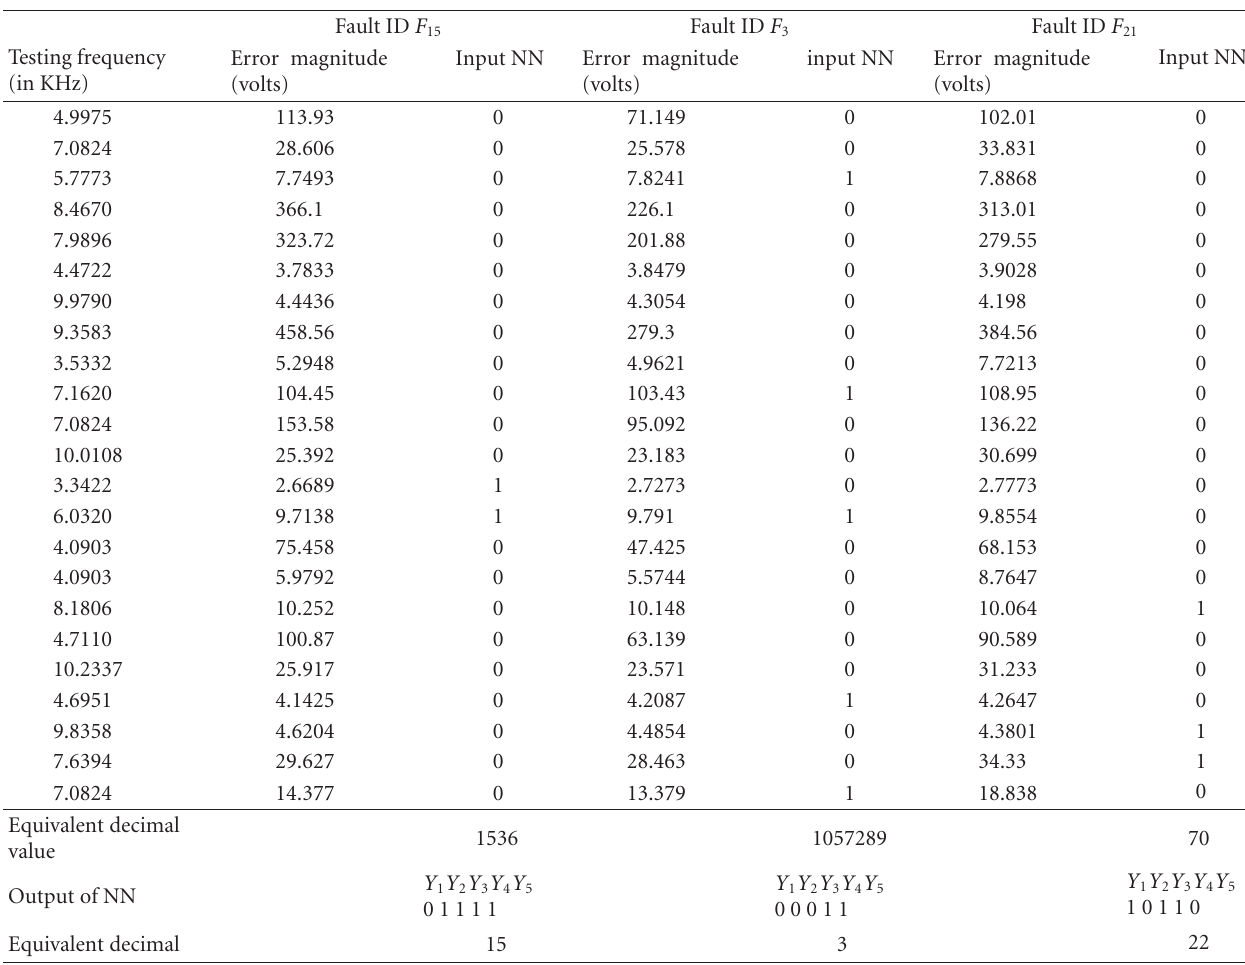
Table 10: ANN inputs and outputs for test cases F 15 , F 3 , and F 21